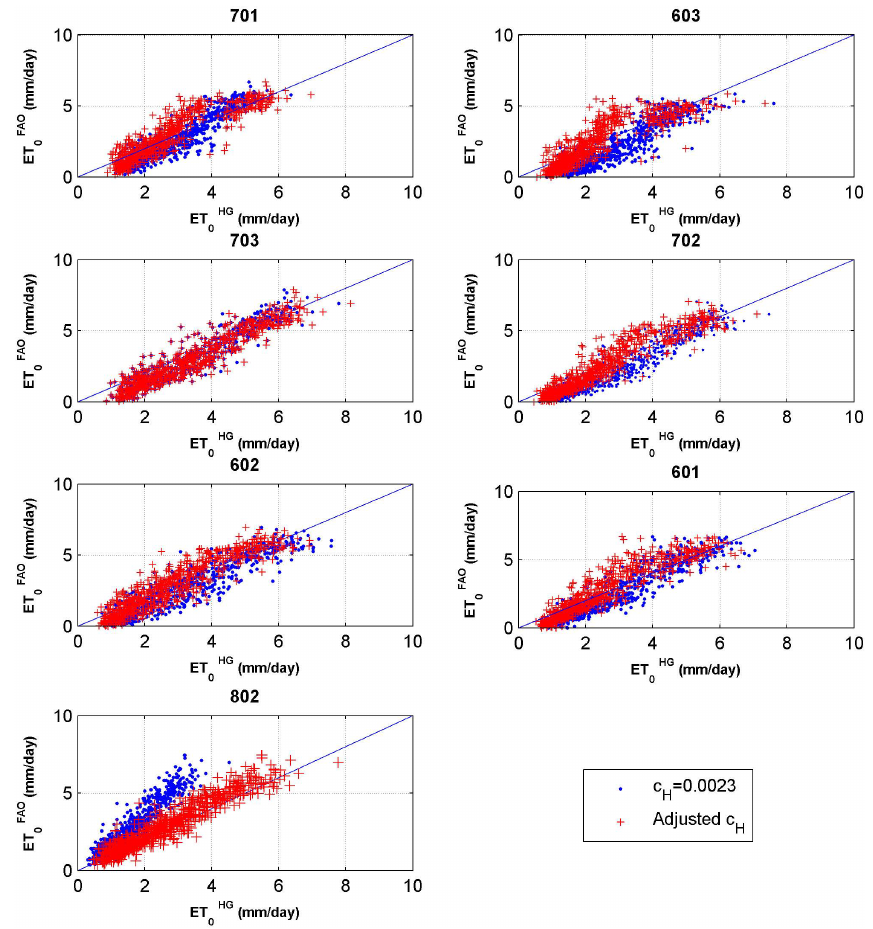
Fig. 5. Daily ET 0 (ET FAO ) vs. daily ET 0 by Hargreaves (ET HG ) with a constant coefficient (0.0023) and adjusted wet/dry season c H at each 0 0 station (601, 602, 603, 701, 702, 703, 802) for the validation period (1 September 2008–2 July